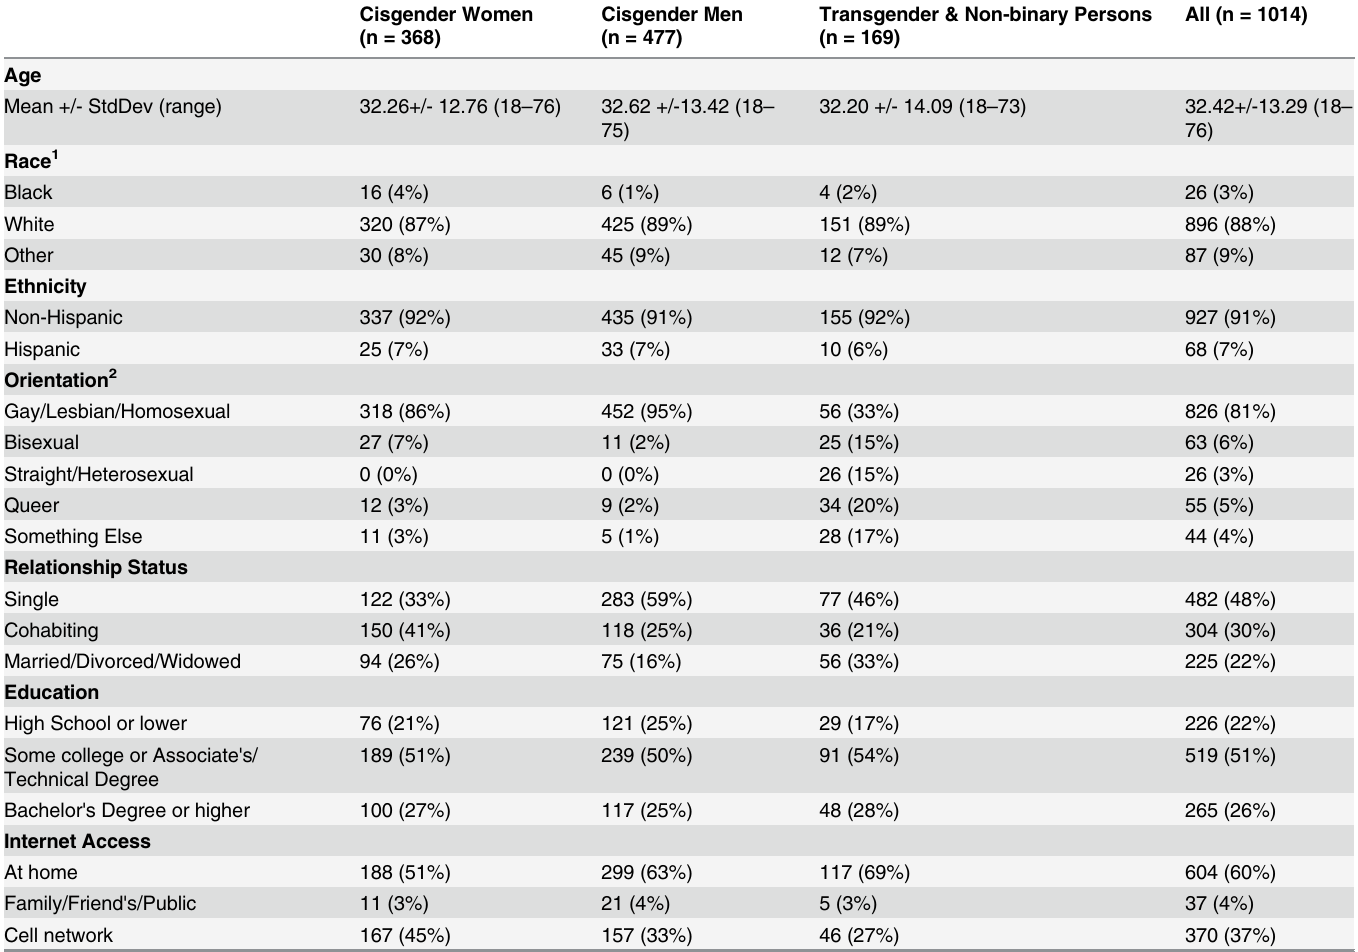
Table 1. Demographic Characteristics of an online sample of rural LGBT